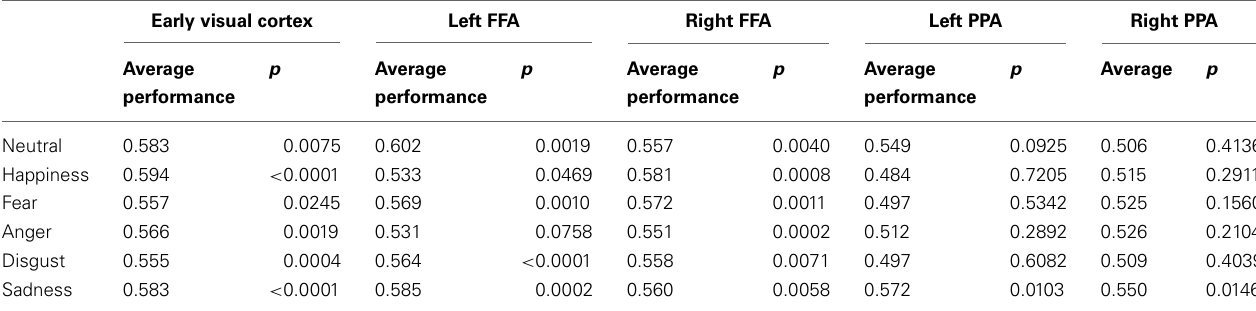
Table 1 | Classifier performance for one vs. all classification in the right and left FFA and